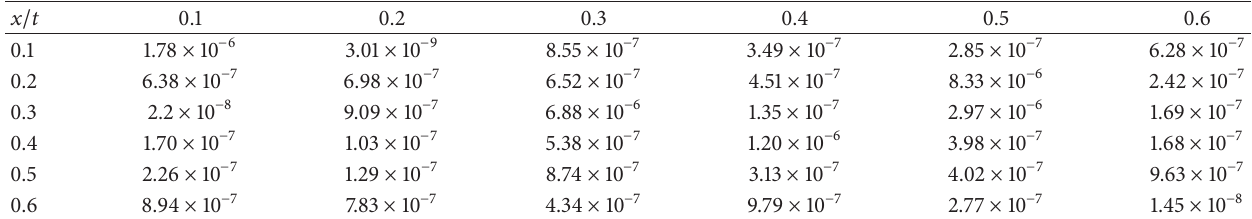
Table 3: The absolute error of Example 11 for initial condition at 0.1 ≤ 𝑥 , 𝑡 ≤ 0.6 .